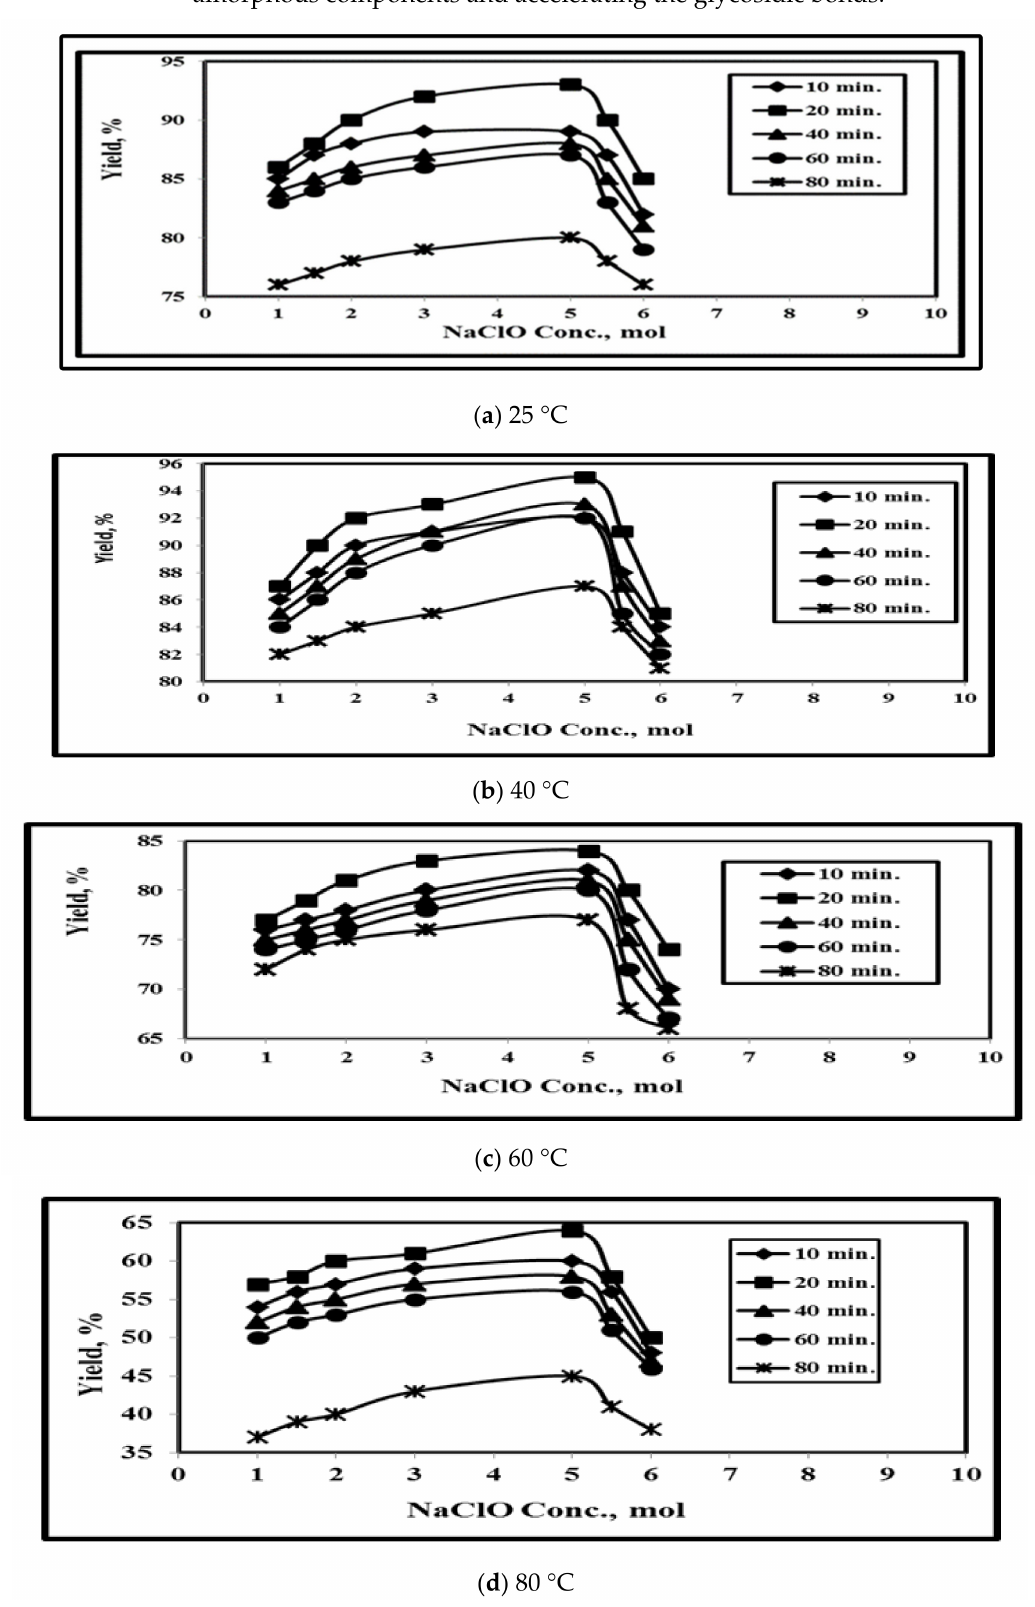
Figure 2. Effect of reaction time and NaClO concentration on the yield % at different test